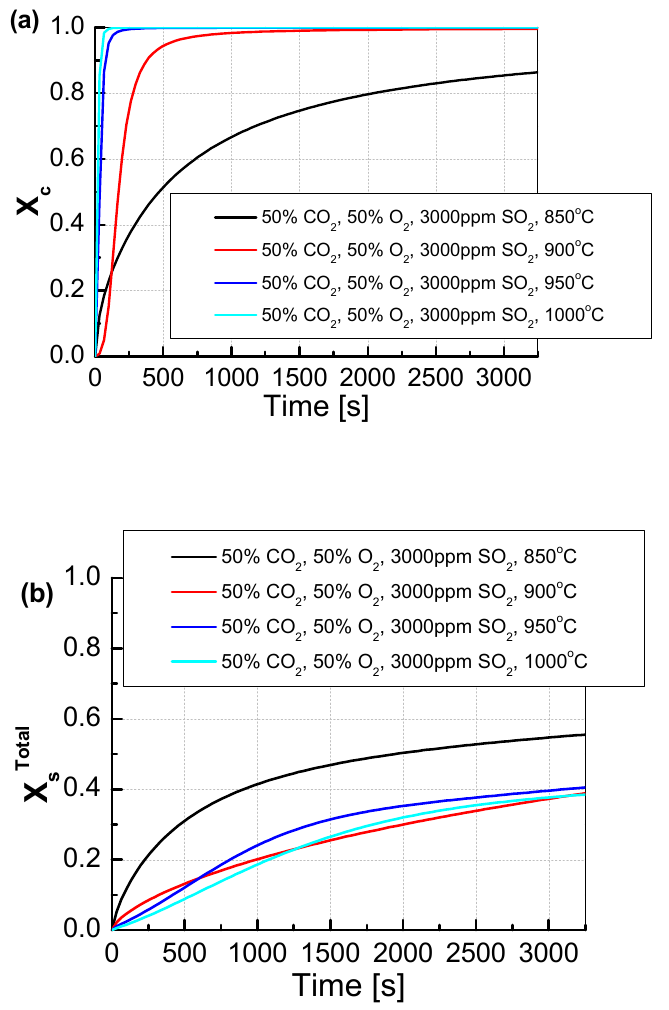
Figure 8. Comparison of the results of the approximation of ( a ) the degree of calcination X c and ( b ) the total degree of X s Total sulfation determined depending on the volume fraction of CO 2 in synthetic exhaust containing 50% CO 2 and 3000 ppm SO 2.